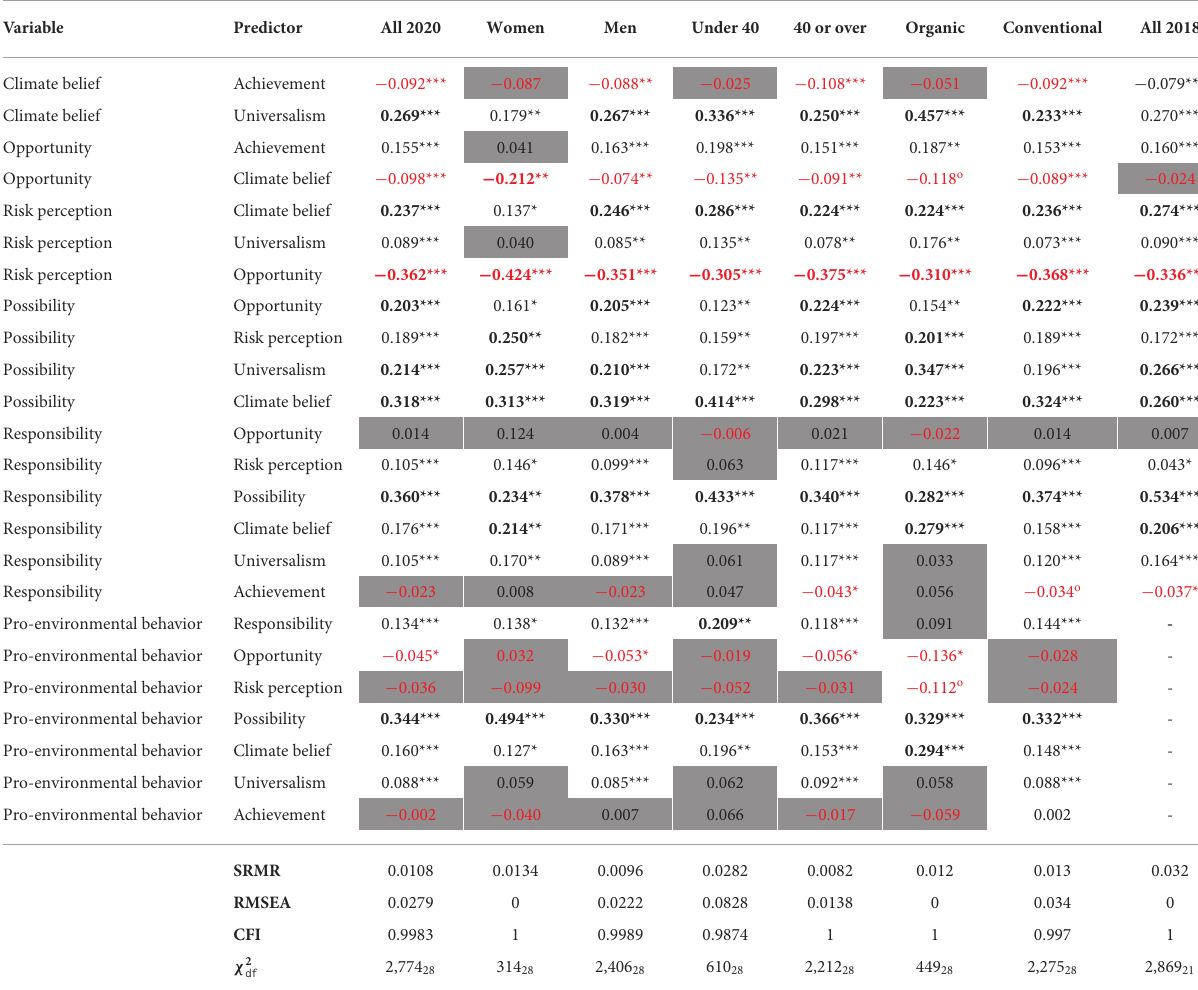
TABLE 2 Path model results for all farmers in 2020 (The base model, N = 1,965), women 2020 ( N = 217), men 2020 ( N = 1,748), farmers under 40 years old ( N = 356), farmers 40 years old or older ( N = 1,609), organic farmers ( N = 239), conventional farmers ( N = 1,694), and all farmers in 2018 ( N =